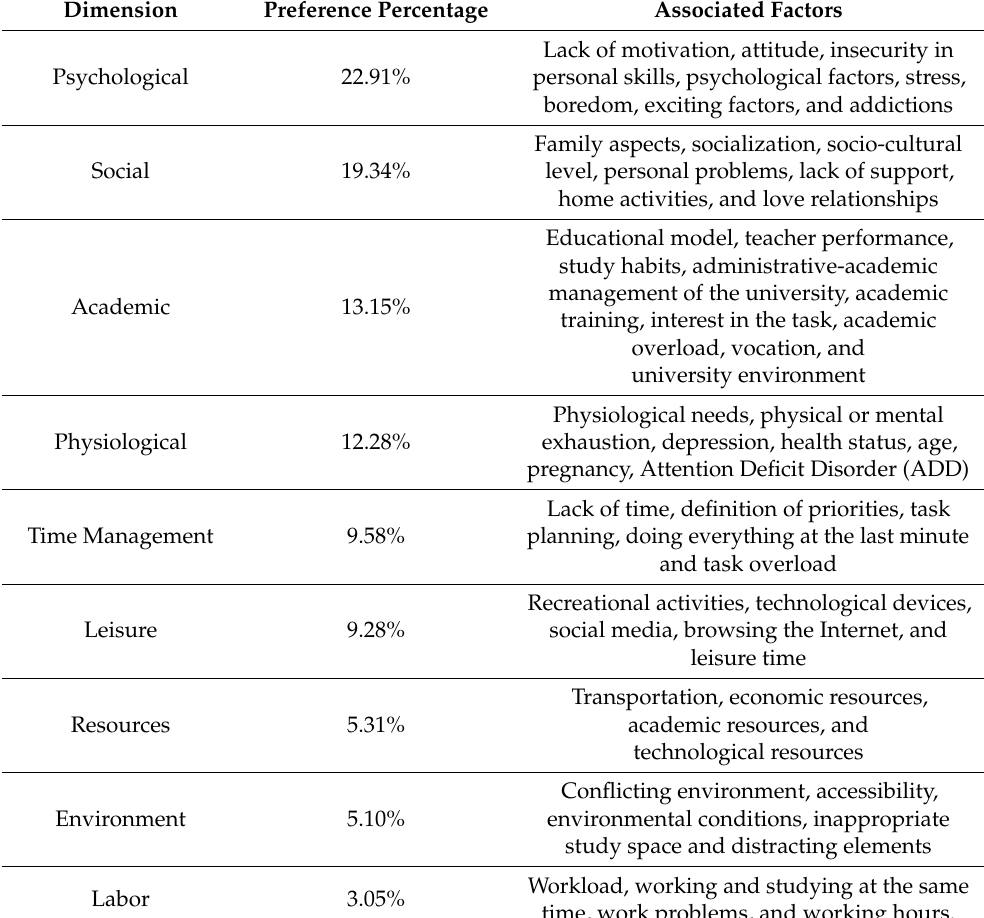
Table 4. Percentage of importance for each dimension and its associated